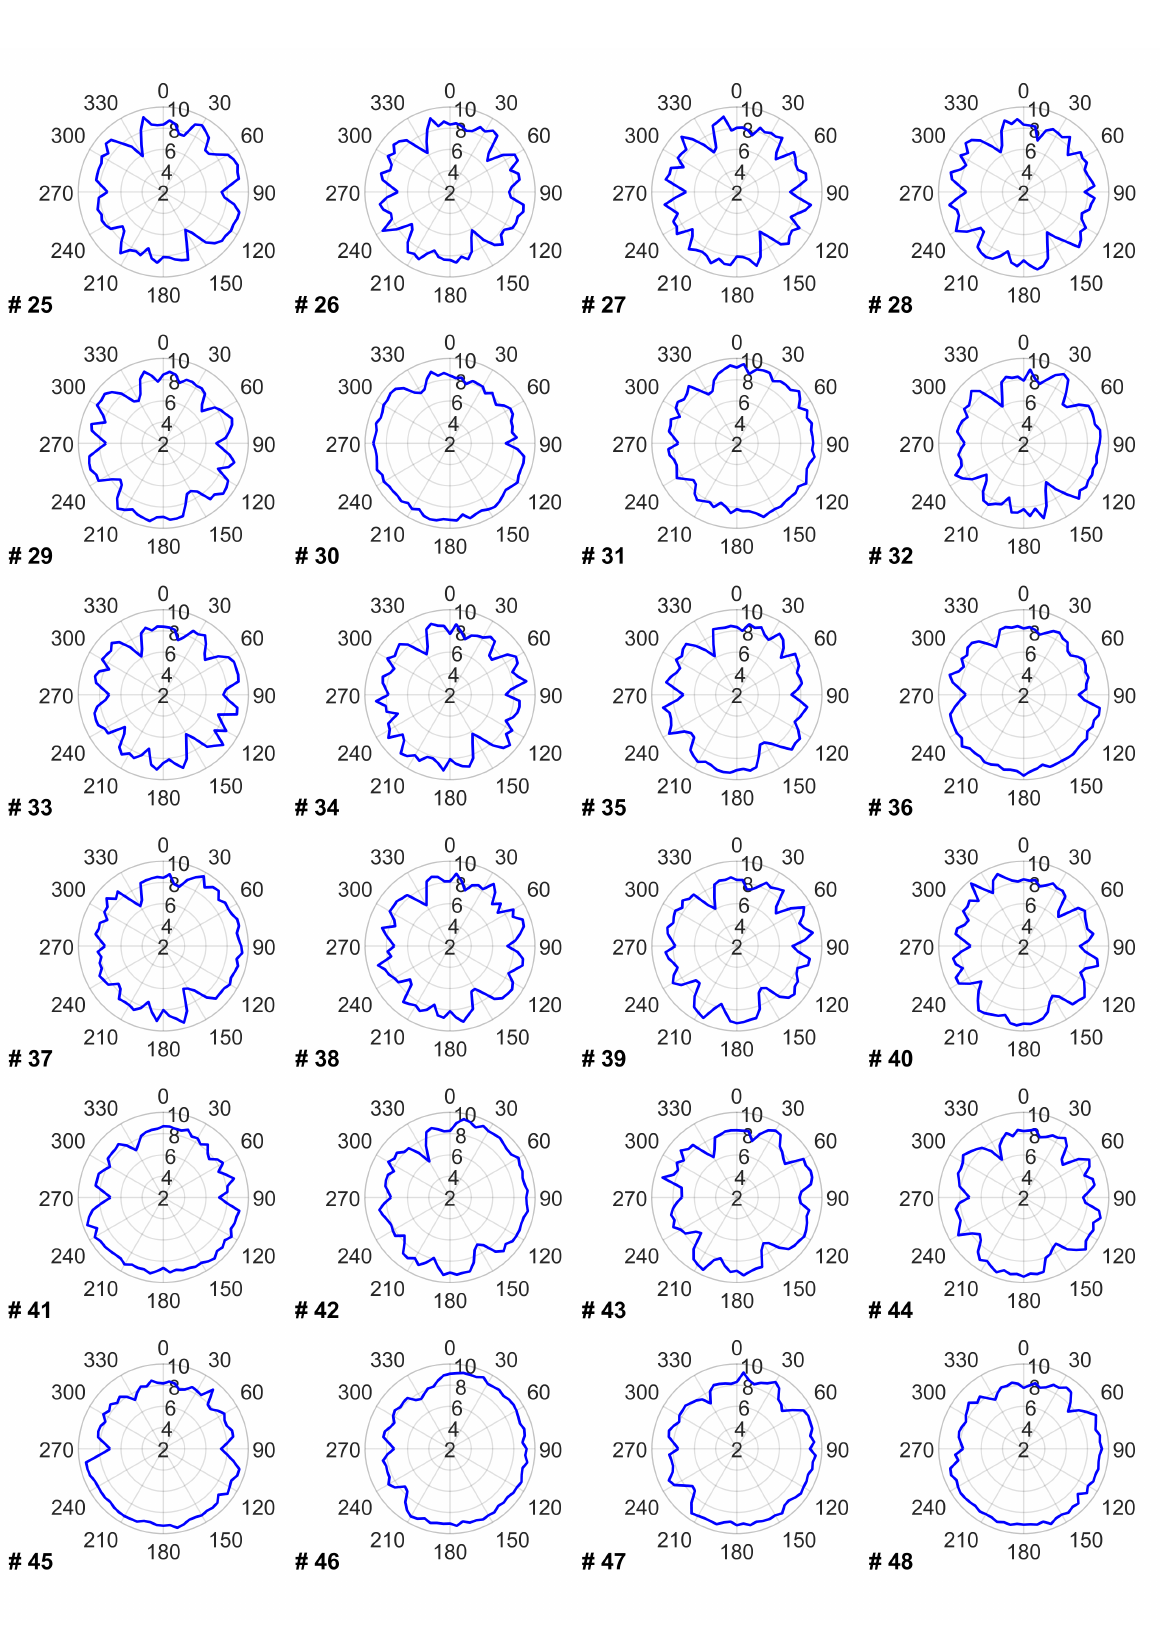
Figure A3. Optimal values of TSR for each turbine in every wind